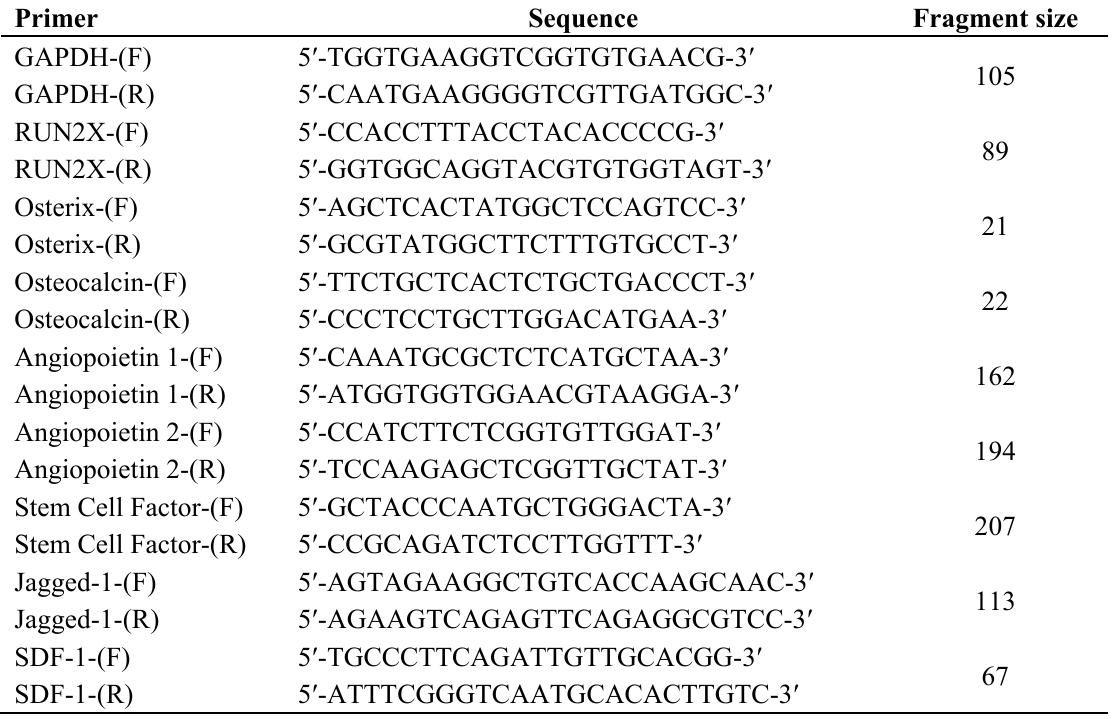
Table 1. Primers used for characterisation of MSC and osteoblasts